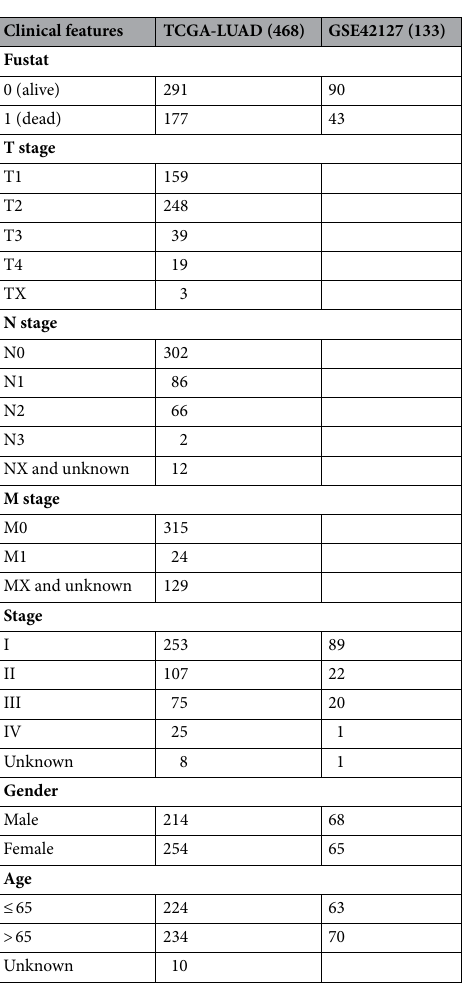
Table 1. Characteristics of the TCGA-LUAD and GSE42127